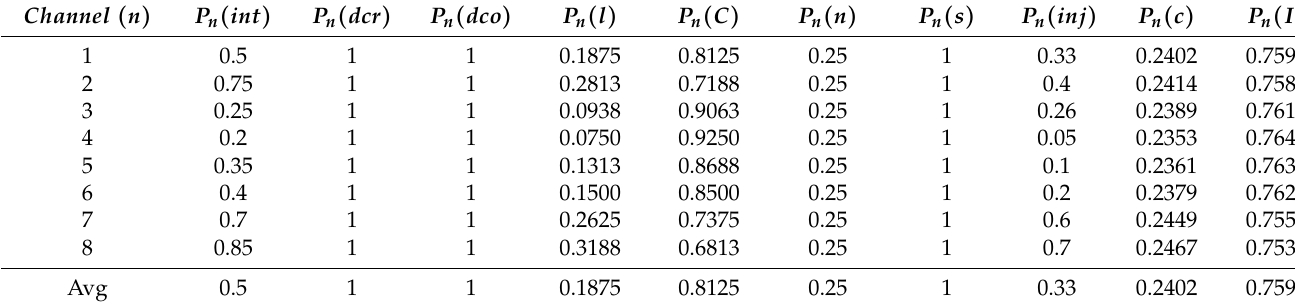
Table 5. Input and output values for an eight-channel